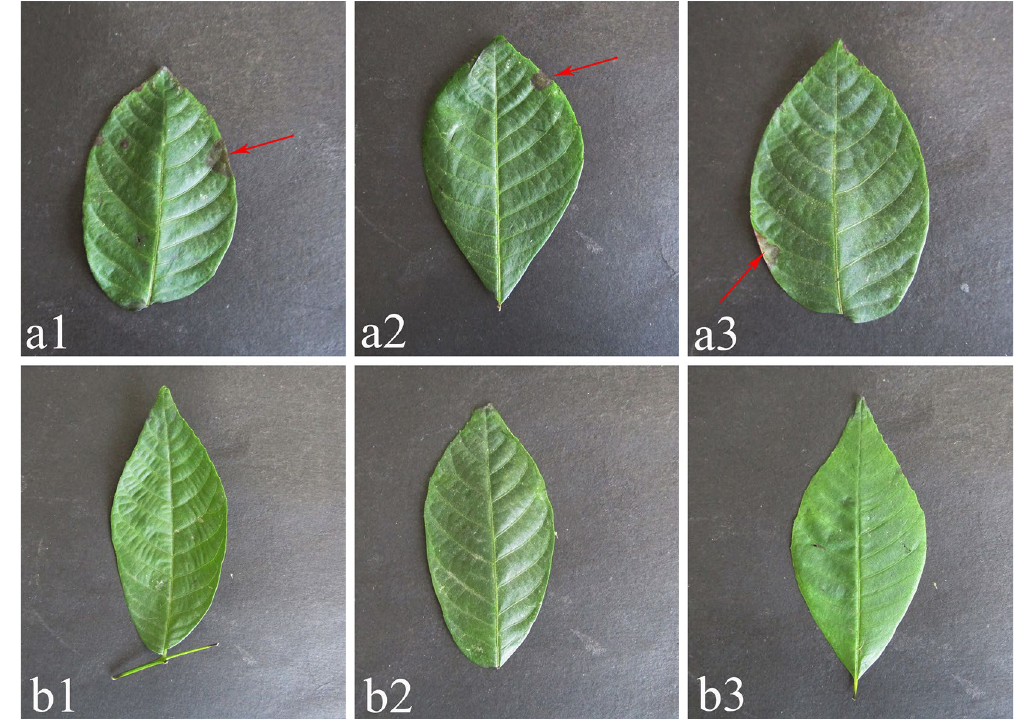
Figure 5. Symptoms observed in vivo experiments after 20 days inoculated with spore suspension. ( a1 – a3 ) Symptoms of inoculation with spore suspension; ( b1 – b3 ) Symptoms of inoculation with sterile